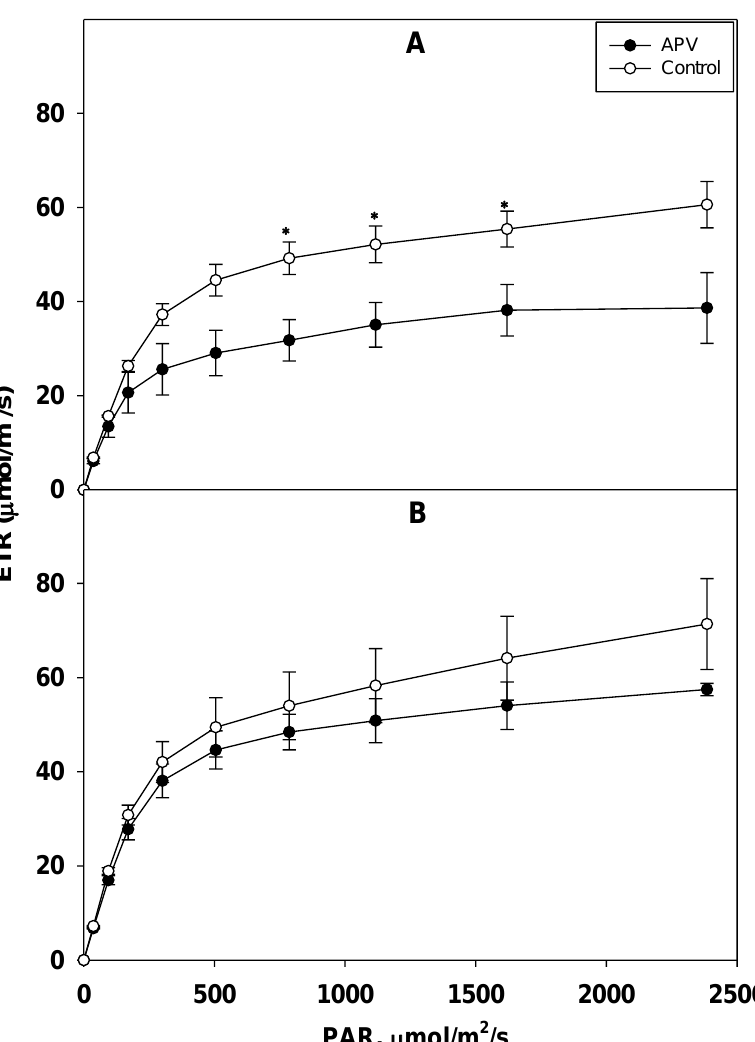
Figure 6. Effect of various PARs on ETR of rice plants at 10 ( A ) and 20 days ( B ) after transplanting (DAT) underneath an agrophotovoltaic (APV) system, Seungju, South Korea. Error bars represent standard deviation ( n = 3). * significantly different between APV system and control plot using a t -test ( p = 0.05).